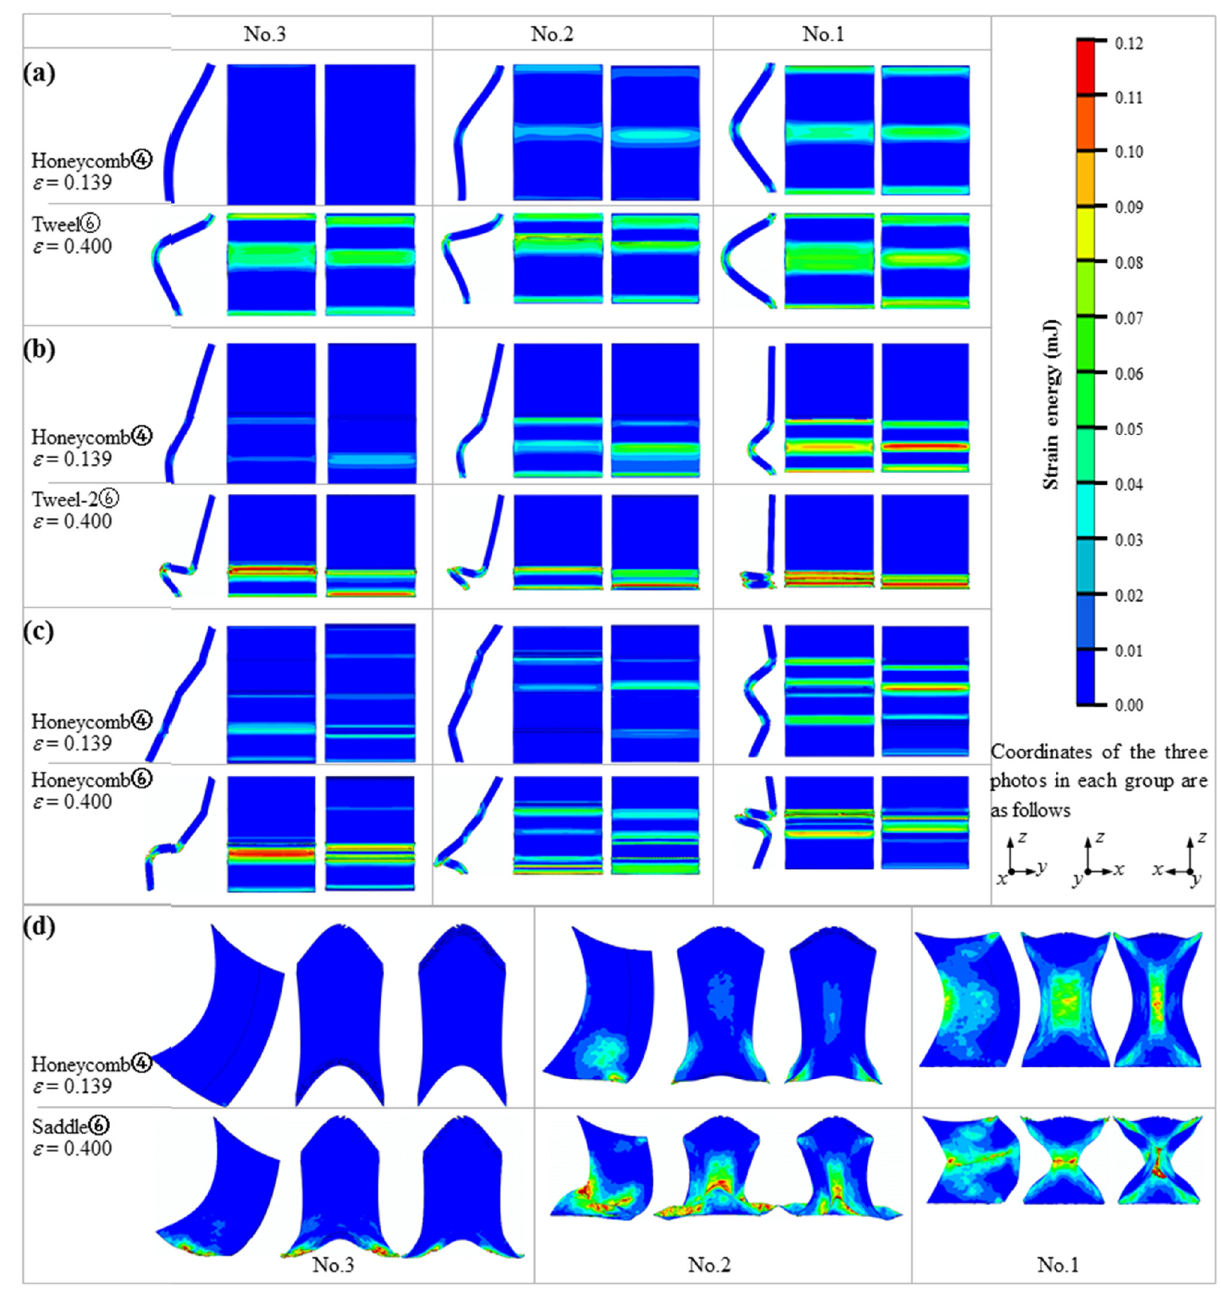
Figure 10: Strain energy fi eld of spokes No. 1, No. 2, and No. 3 at di ff erent time points for ( a ) Tweel; ( b ) Tweel - 2; ( c ) honeycomb; and ( d ) saddle tire FE models. The honeycomb ④ corresponds to the nominal strain of 0.139, which is chosen as the fi rst time point, and there is no element failure in the four tire